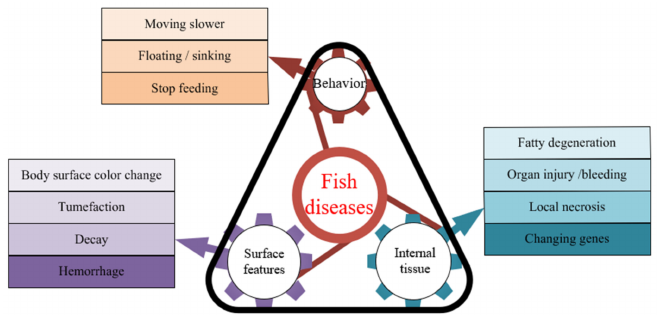
Figure 3. The surface and internal tissues as well as behavioral changes that may result from fish